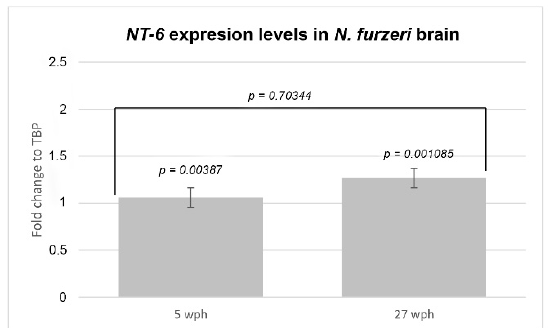
Figure 2. Expression levels of NfuNT-6 mRNA in the brain of young and old N. furzeri . Comparable expression levels of NfuNT-6 mRNA in the whole brain of young and old animals ( p -value: 0.70344). For 5 and 27 wph, NfuNT-6 mRNA was normalized to TBP and expression levels were compared using ΔΔ CT method ( p -value 5wph = 0.00387; p -value 27wph = 0.001085).